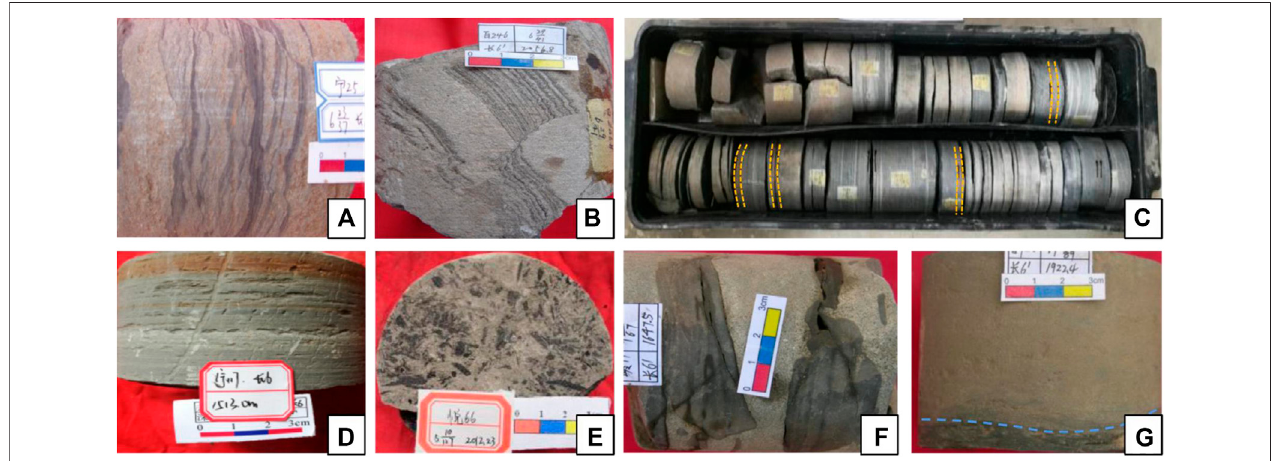
FIGURE 7 | Core sign for triggering mechanism of gravity- fl ow in the study area.